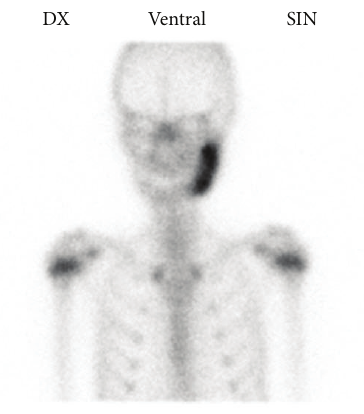
Figure2:Bonescintigraphyofpatientcase1showsincreaseduptake of tracer at the left side of the